Question: What style of plot is this figure drawn as?
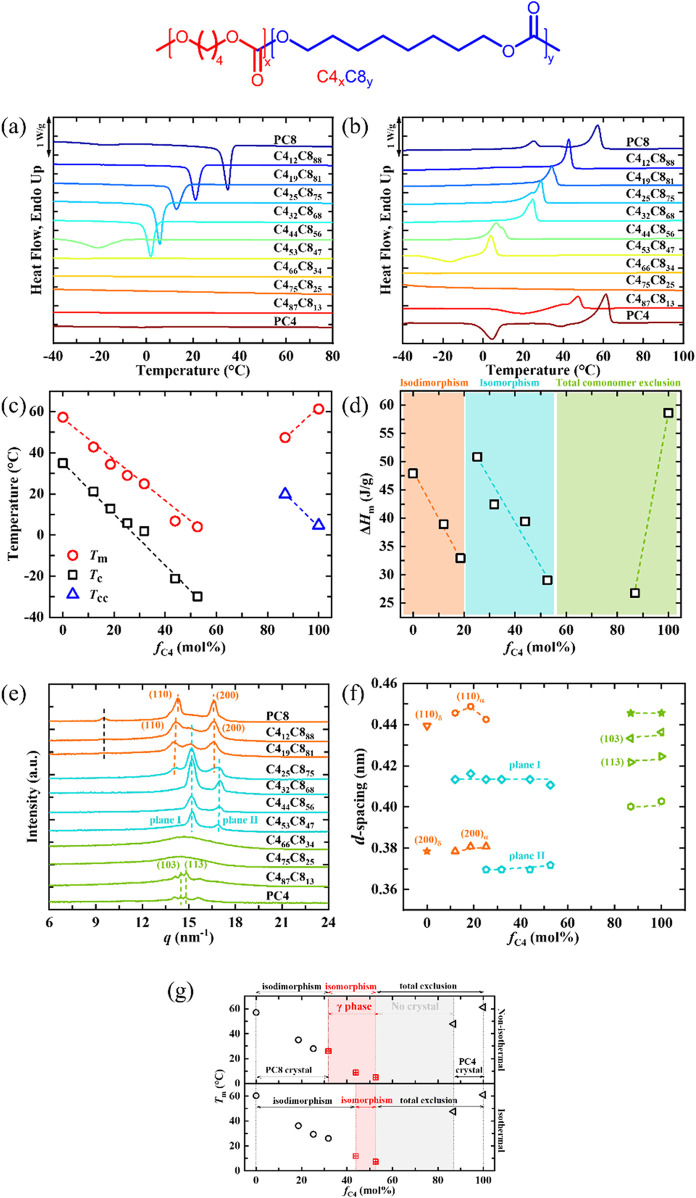
Answer: line